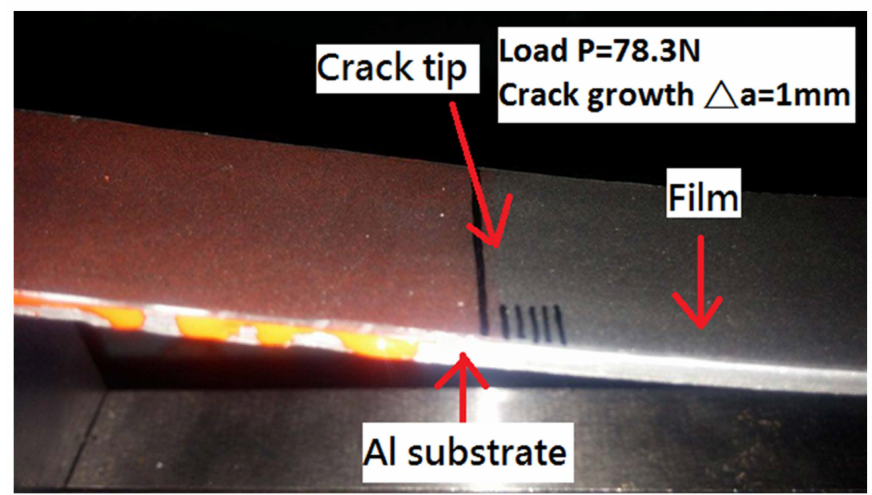
Figure 7. Initiation of crack growth at critical